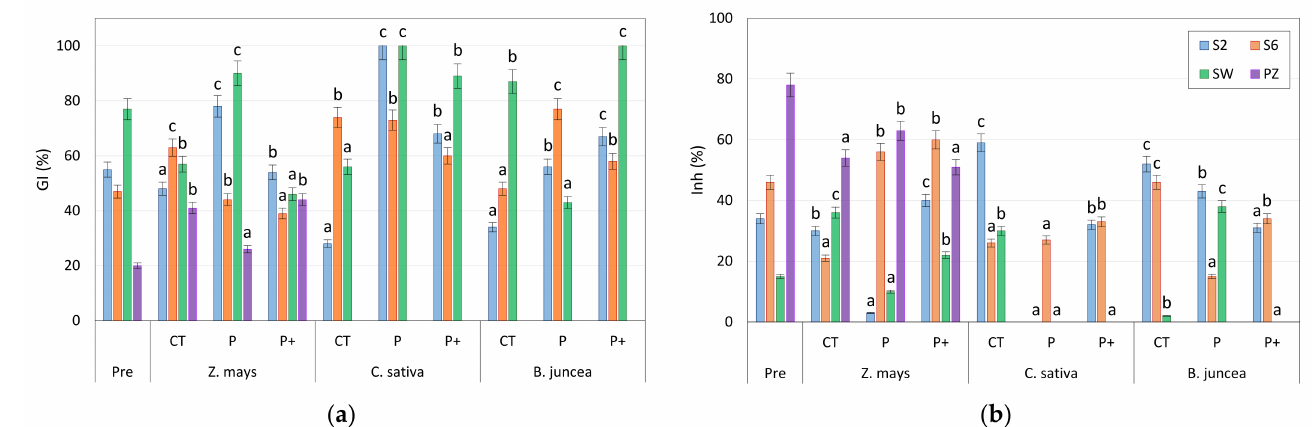
Figure 3. ( a ) Germination index (GI%) and ( b ) root elongation inhibition (Inh%) for Z. mays , C. sativa, and B. juncea grown on soil control (CT) and As-contaminated soil treated with phosphate (P). The addition of PGPR bacteria (first set of isolates) is indicated with a “+” sign. Values are the mean of three replicates, and the error bars show the standard deviation. Values with different letters are significantly different at the 5% probability level (Tukey’s test).